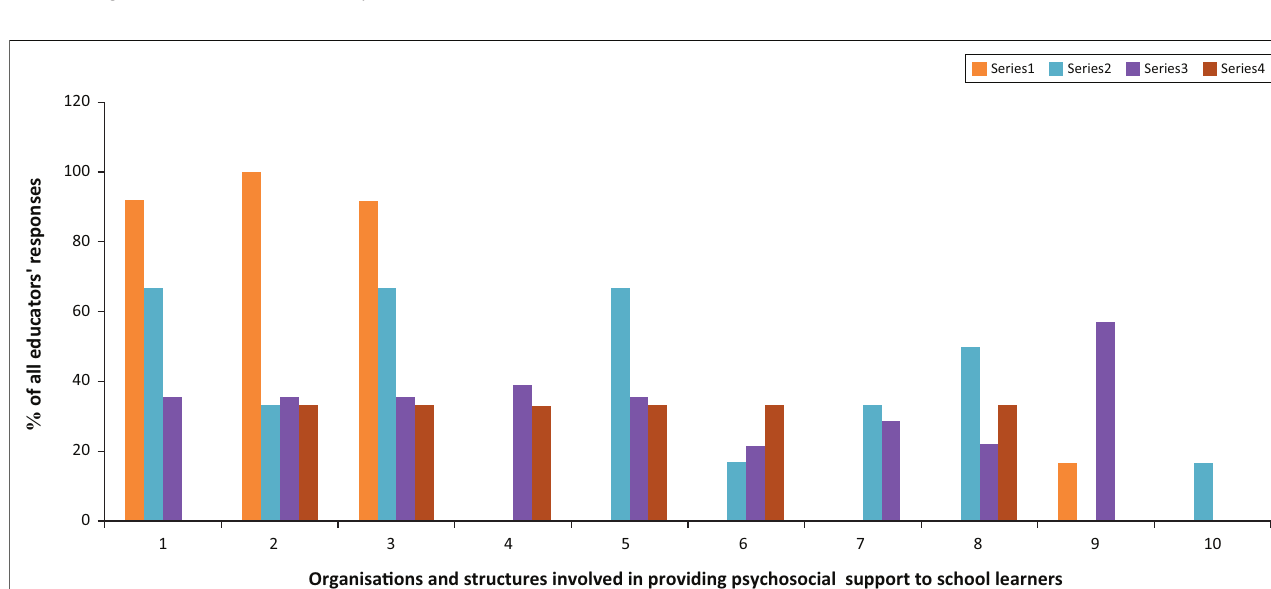
FIGURE 4: Organisations and structures involvement collated from insights of the collected data.